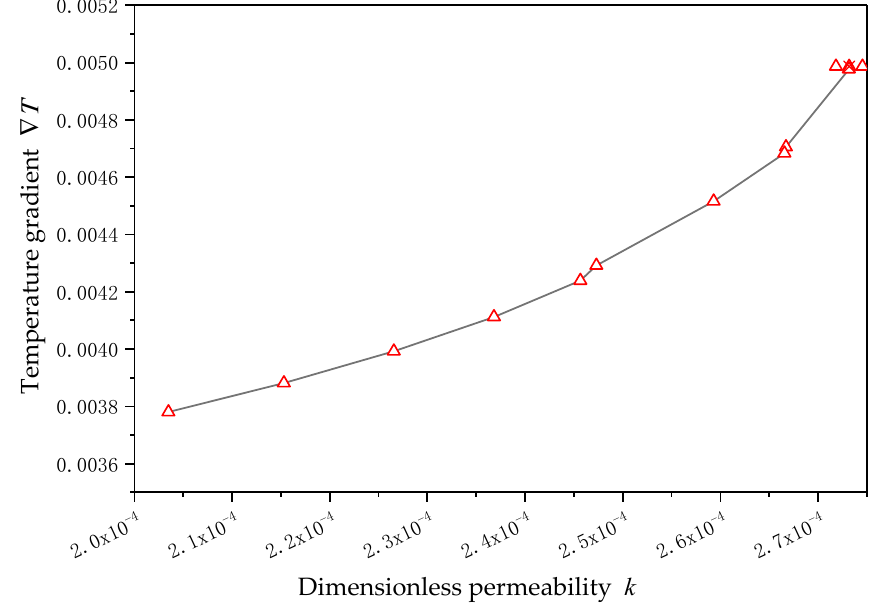
Figure 19. The relationship between dimensionless permeability and temperature gradient of parallel arrangement structure.